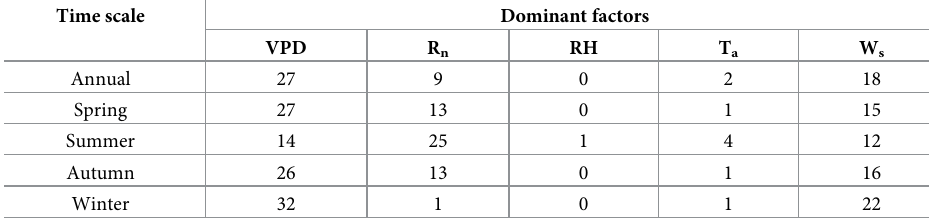
Table 3. Number of stations with dominant factors of PET trends at annual and seasonal scales during 1970